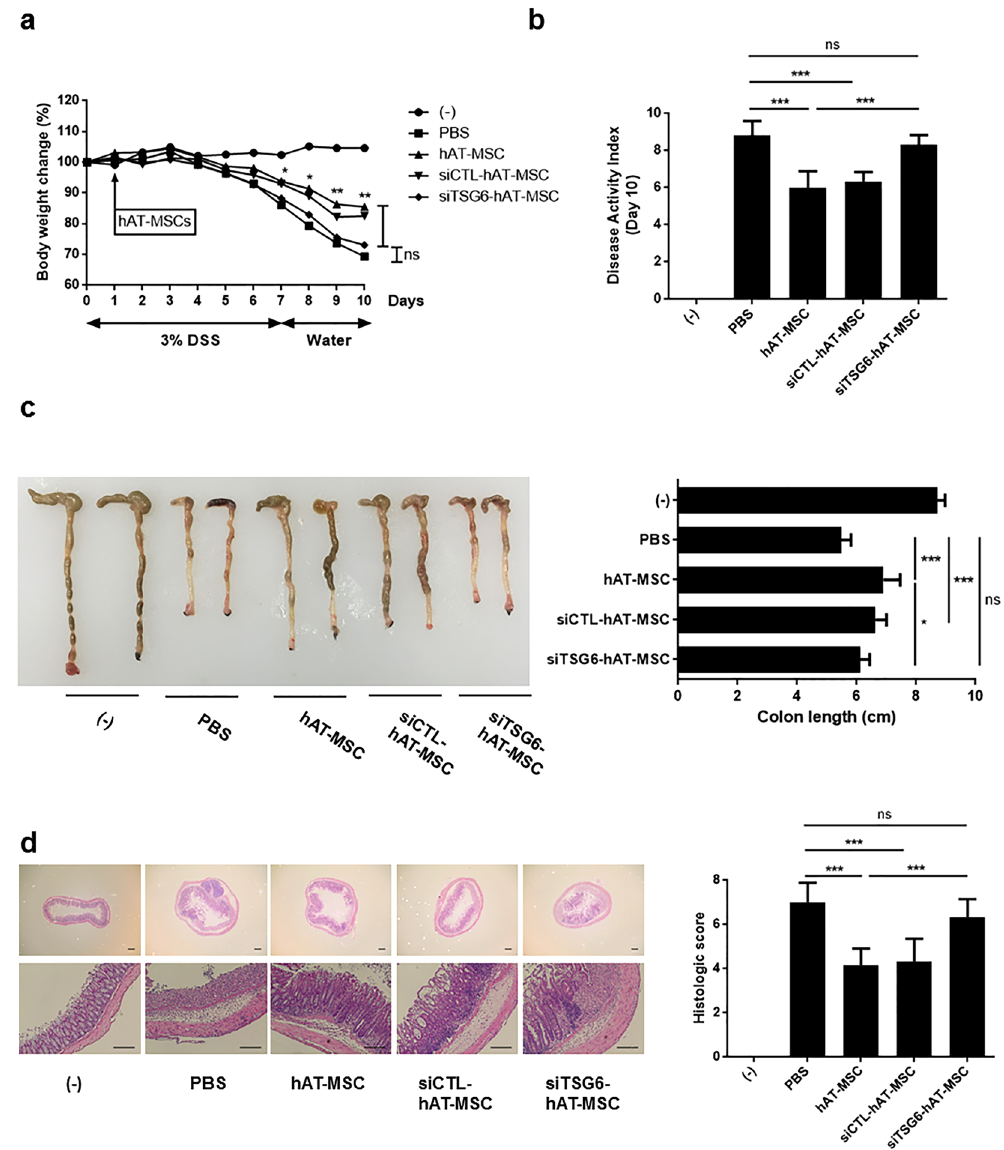
Figure 7. TSG-6 knockdown in hAT-MSCs inhibits their effect on IBD. ( a ) Body weight of animals injected with siTSG6-hAT-MSCs, siCTL-hAT-MSCs, or naïve hAT-MSCs was measured every day during the experiment, and expressed in terms of the relative change from the weight measured on day 0. ( b – d ) Mice were sacrificed on day 10 to evaluate clinical severity. ( b ) DAI, ( c ) colon length, and ( d ) representative colon tissue sections stained with H&E and histological scores are shown. Bars = 100 µ m. Six to eight mice per group were used. Results are presented as mean ± standard deviation. * P < 0.05, ** P < 0.01, *** P <